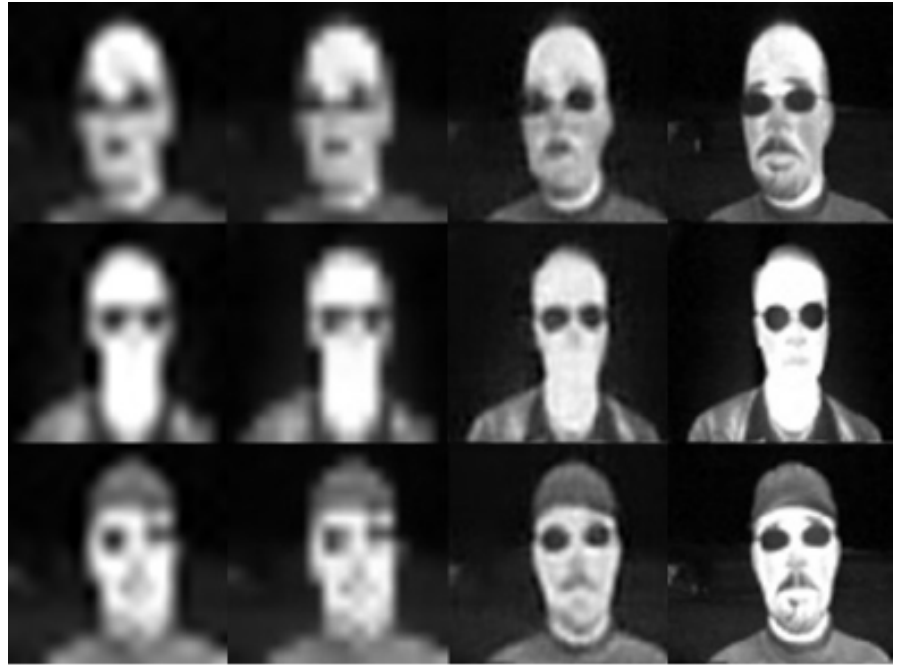
Figure 8. DeepSIRF 2.0 results for the thermal LWIR images, from left to right: low-resolution images; bicubic; DeepSIRF 2.0; high-resolution image